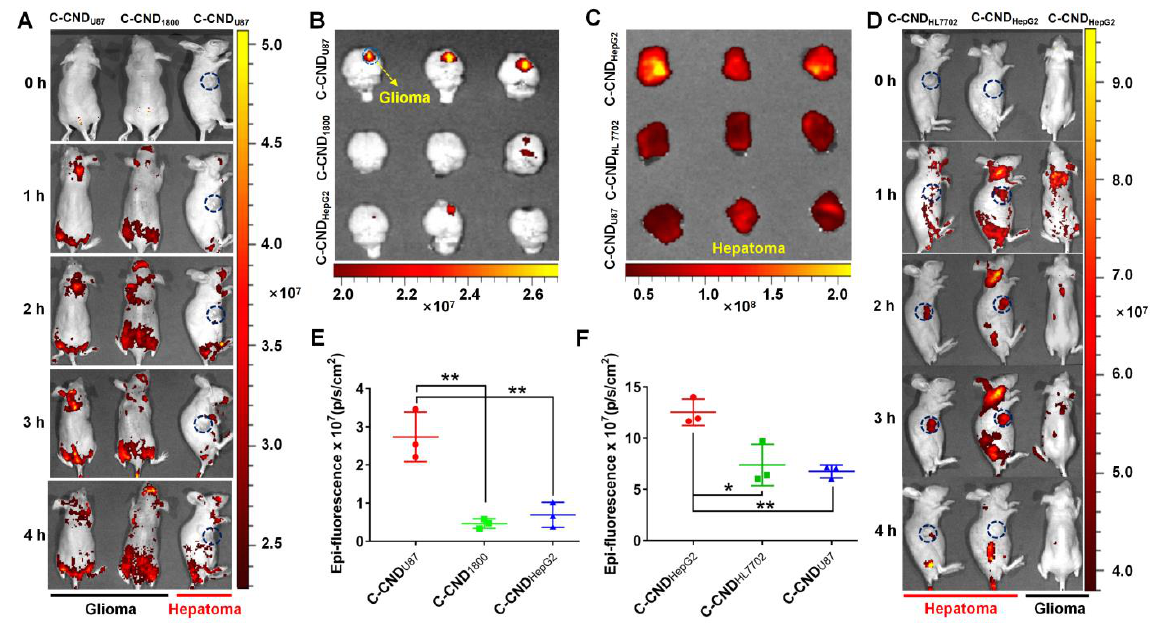
Figure 4. ( A ) Living imaging of orthotopic U87 glioma-bearing mice after intravenous injection of C-CND U87 and C- CND 1800 , and the subcutaneous hepatoma-bearing mice after intravenous injection of C-CND U87 at different time periods. ( B ) Ex vivo imaging of brains of U87 mediated orthotopic glioma-bearing mice collected at 3 h post intravenous injection of C-CND U87 , C-CND 1800 , and C-CND HepG2 ( n = 3). ( C ) Ex vivo imaging of tumors of hepatoma-bearing mice after 3 h intra- venous injection of C-CND HepG2 , C-CND HL7702 , and C-CND U87 ( n = 3). ( D ) Living imaging of the subcutaneous hepatoma- bearing mice after intravenous injection of C-CND HepG2 and C-CND HL7702 , and U87 glioma-bearing mice after intravenous injection of C-CND HepG2 at several times. Quantified fluorescence intensity of gliomas of orthotopic U87 glioma-bearing mice collected after 3 h intravenous injection of C-CND U87 , C-CND 1800 , and C-CND HepG2 ( E ) and tumors of hepatoma-bear- ing mice after 3 h intravenous injection of C-CND HepG2 , C-CND HL7702 , and C-CND U87 ( F ) ( n = 3). Notes: * p < 0.05; ** p <